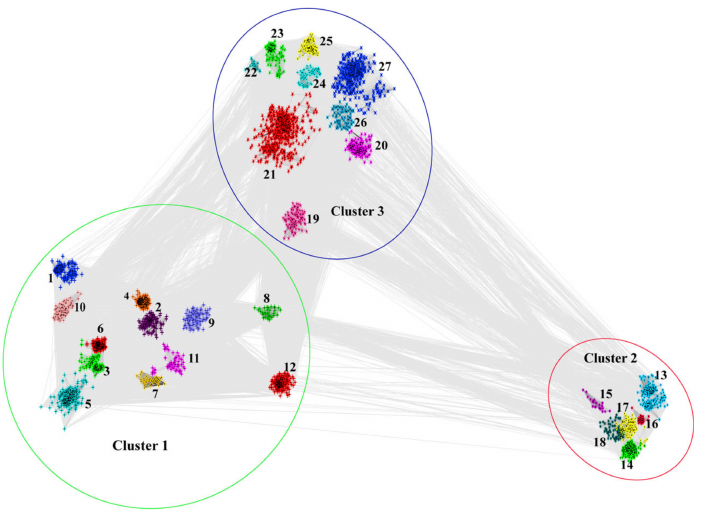
Figure 2. CLANS clustering of 3816 SET domain sequences obtained from 229 whole-genome sequenced fungal species. Three Clusters and 27 groups among the 3816 SET domain sequences were identified. Those 27 groups within these three Clusters were marked with different colors and